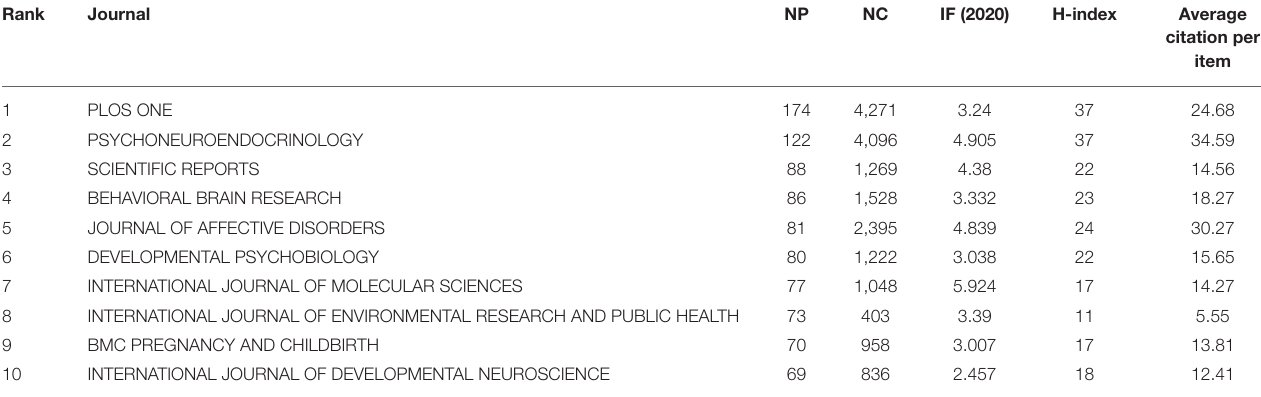
TABLE 4 | Top 10 most active